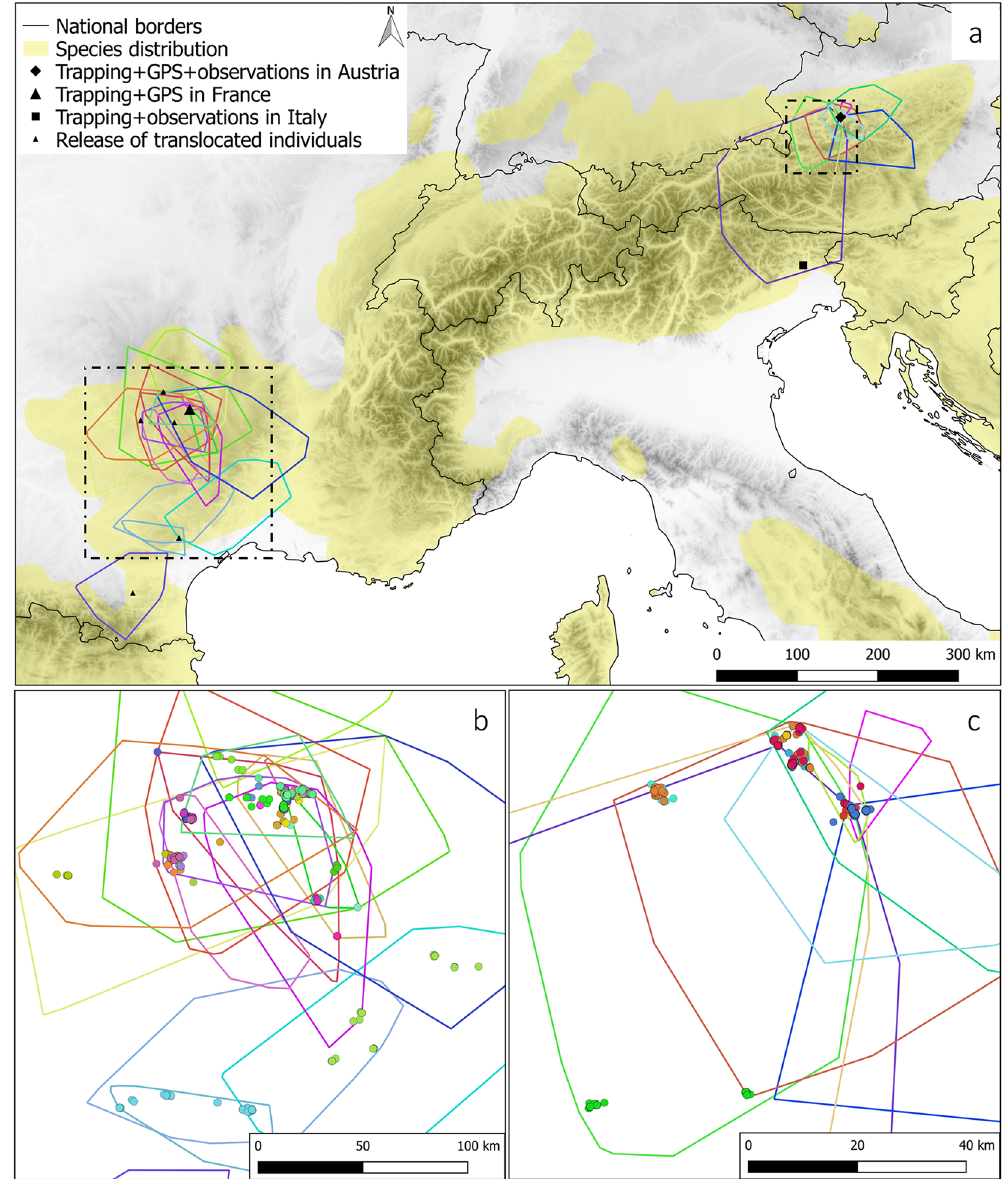
Figure 2. Fission-fusion dynamics of GPS-tagged ravens. ( a ) The three study areas are marked with a diamond for AUT, a square for ITA and a triangle for FRA. All individuals with GPS-tags have been captured and released in AUT or in FRA (small triangles indicate release points for translocated individuals). The minimum convex polygon (100%) of each individual is represented in different colors to roughly cover their space use. The dashed squares indicate the areas of ( b,c ), both of which show the GPS-locations as points (5,004 for FRA and 1,668 for AUT) of fusion events at different sites. The colors of the points indicate different combinations of ravens. The maps were created using QGIS 2.18.1, an Open Source Geospatial Foundation Project: http://qgis.osgeo.org, QGIS Development Team,